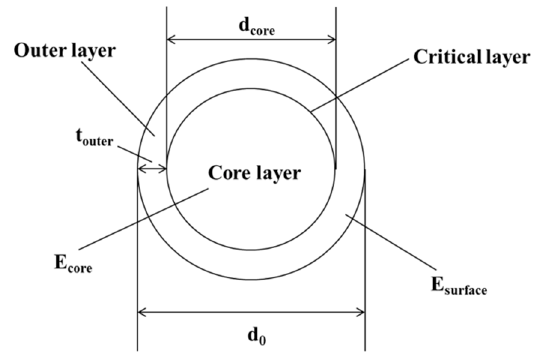
Figure 1. Skin–core structure model of carbon fiber.